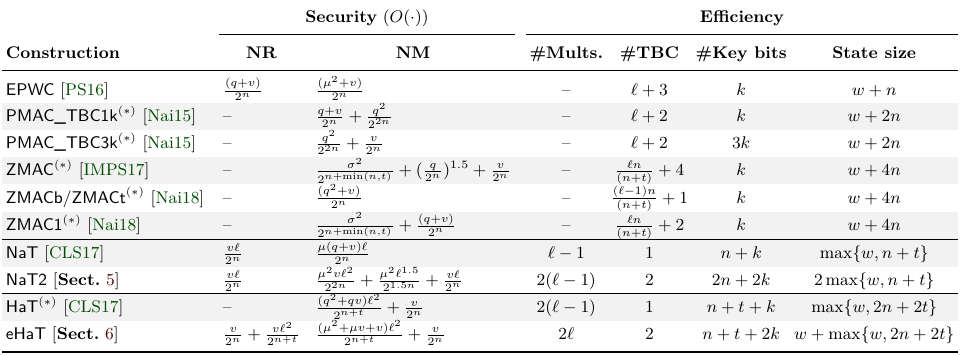
Table 1: Comparison of existing TBC- and nonce-based MACs with BBB security with our proposal assuming an n -bit, O ( ‘/ 2 n )-AU polynomial hash function using n -bit hash keys (and t -bit, O ( ‘/ 2 t )-AU polynomial hash function using t -bit keys when used for tweaks) for ‘ -block inputs, and a TBC with n -bit state and t -bit tweaks. NR = nonce-respecting setting; NM = nonce-misusing setting. µ = #faulty nonces (Section 2), q = #MAC queries, v = #verification queries, σ = #blocks in MAC queries, #Mults. = #field multiplications, #TBC = #TBC calls for ‘ -block messages, State size in bits, ( ∗ ) = deterministic MACs have no µ term, their mac bound is shown in the NM setting. w = Size of the